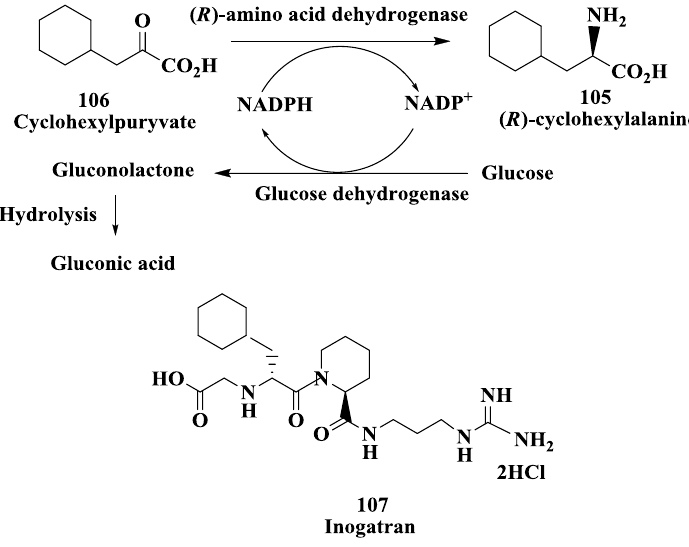
Figure 29. Thrombin inhibitor inogatran: Enzymatic synthesis of ( R